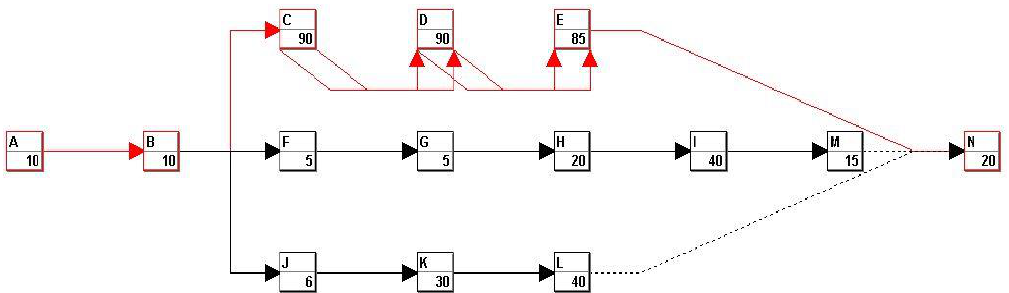
Fig. 4. Activity network diagram (critical path: A-B-C-D-E-N) (developed by the